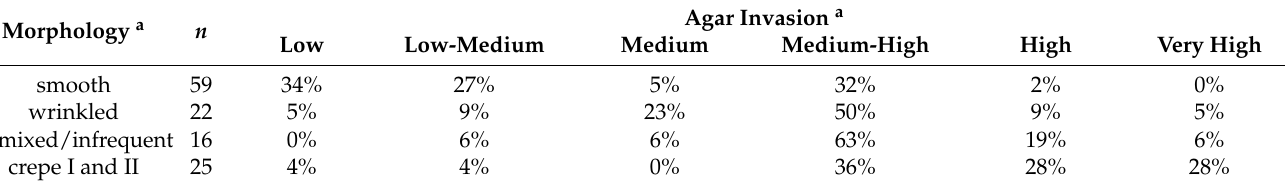
Figure 4. Emergence of colony morphotype over time. ( A ) Development of colony morphotype and ( B ) agar invasiveness scoring the same plates consecutively from 4 days to 10 days after inoculation. Isolates with low biofilm formation capacity (left panels), intermediate biofilm formation capacity (middle panels), and high biofilm formation capacity (right panels) were scored for the most frequent colony morphotype visible. Of note, HBF isolates rated “smooth” still developed minor frequencies of non-smooth colonies. See Supplementary Figure S1 for scoring references. Table 1. Agar invasiveness and colony morphology.